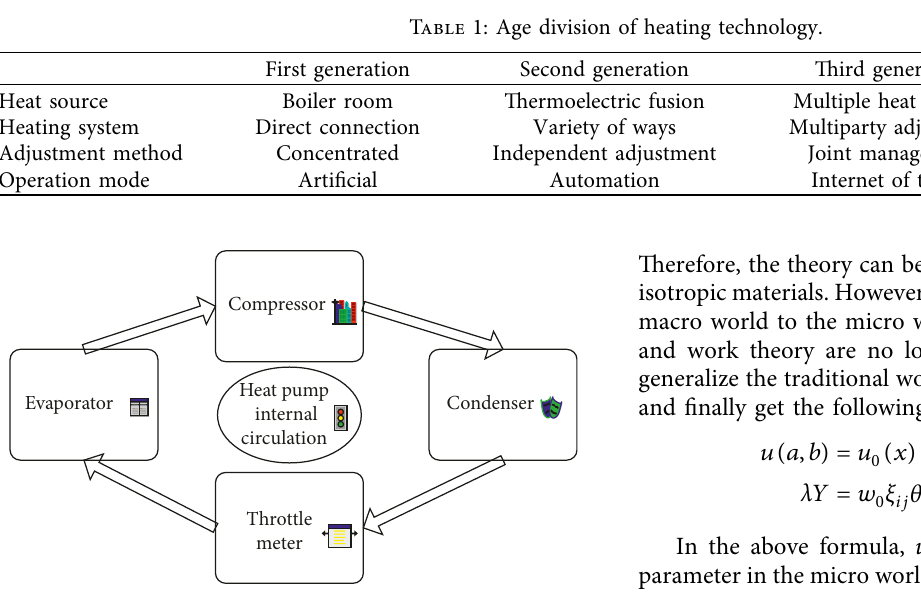
Figure 4: Schematic diagram of heat pump cooling and heating linkage.